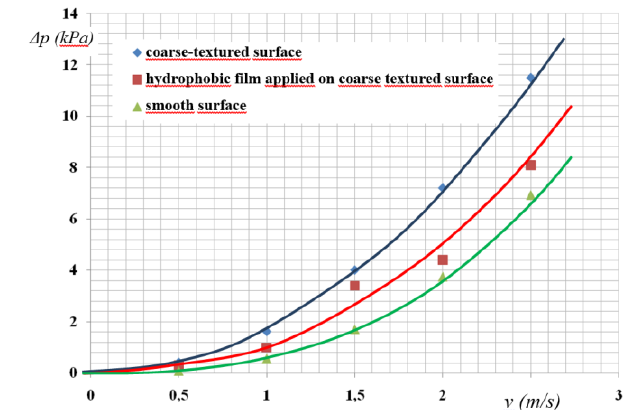
Fig. 14 P ressure difference versus the velocity of the liquid for different quality of surfaces